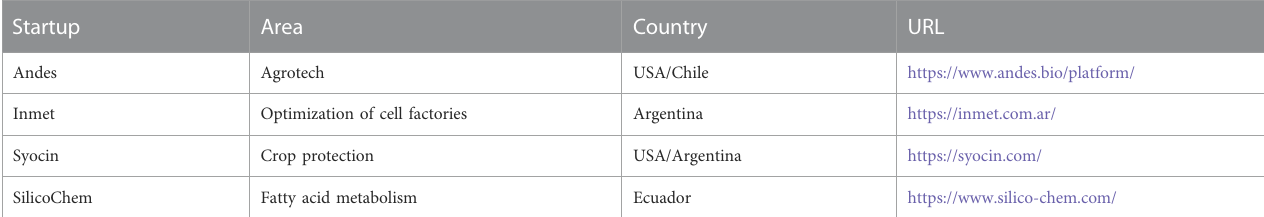
TABLE 2 Examples of South American startups that rely on SynBio.